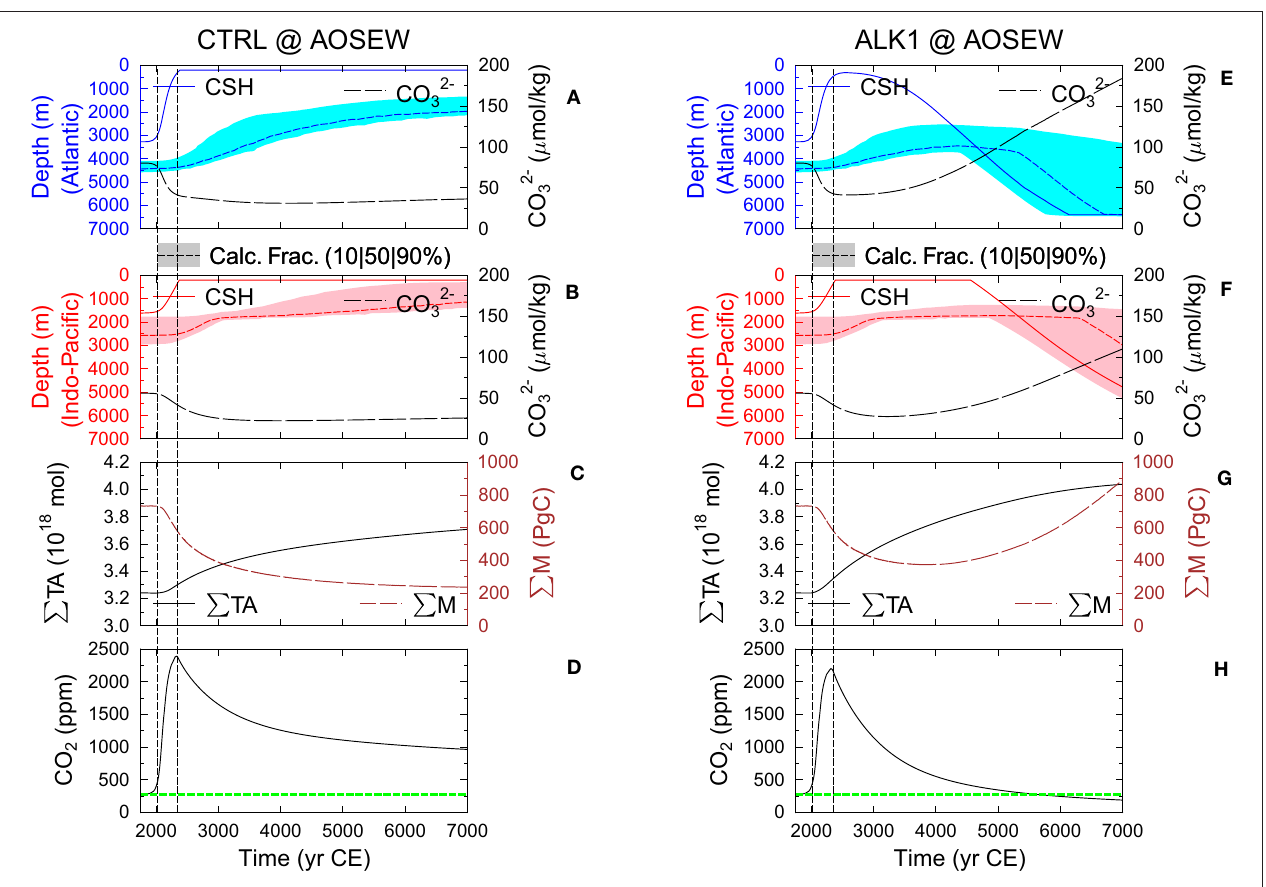
FIGURE 4 | Details for CTRL (left) and ALK1 (right) in AOSEW setup. Calcite saturation depth (CSH), carbonate fraction (shaded area covers depths from 10% (lower bound) to 90% (upper bound) with 50% as short broken line in-between) in sedimentary mixed layers, and CO 2 − 3 -ion concentration in the equatorial ocean of the (A,E) Atlantic or (B,F) Indo-Pacific. (C,G) Sum of total alkalinity in the ocean ( TA) and global amount of CaCO 3 integrated over all sedimentary mixed layer ( Atmospheric CO 2 , and green horizontal line marks the pre-industrial concentration of 278 ppm. Vertical lines are at 2020 CE (onset of alkalinization) and 2350 CE P (emissions back to 0).